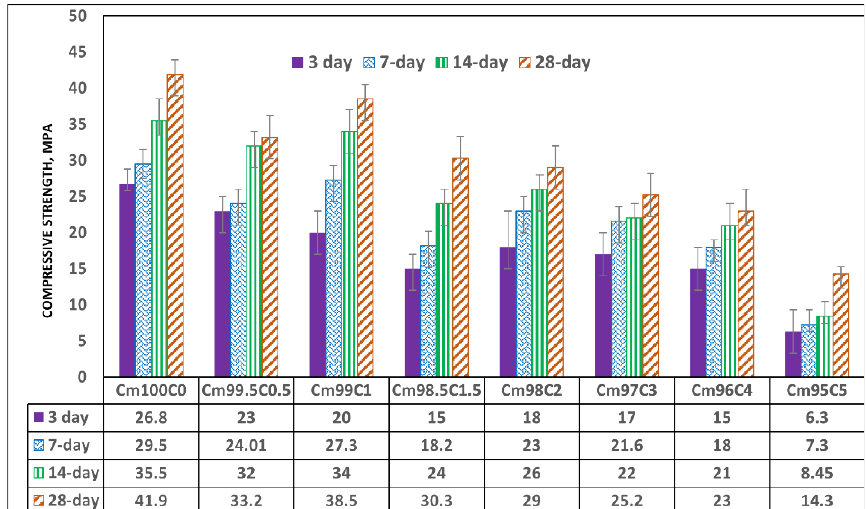
Figure 10. Compressive strength of coffee-silverskin-blended mortar.